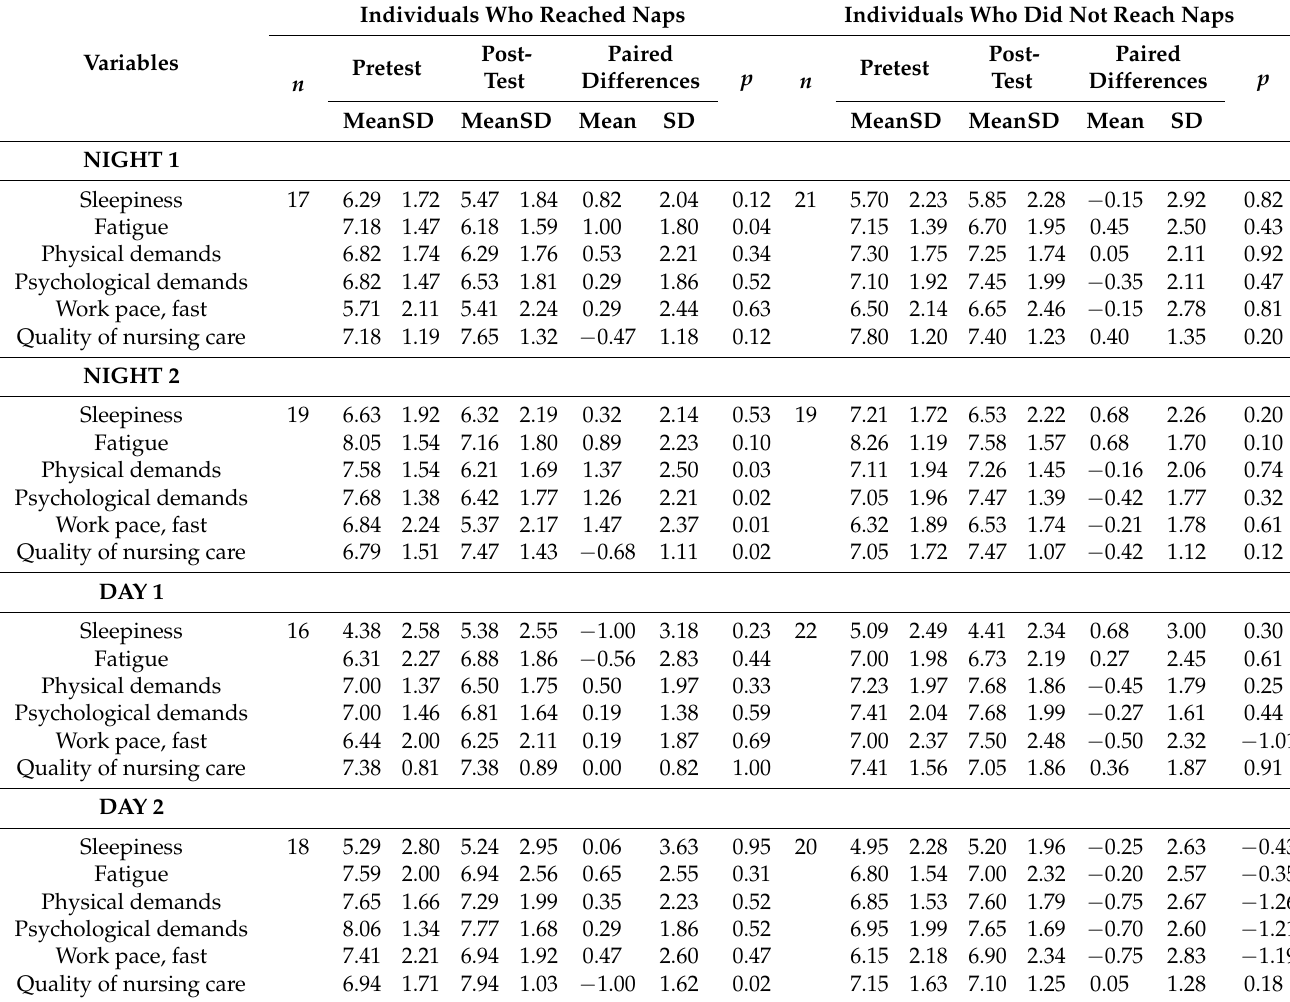
Table 2. Differences in self-reported sleepiness, fatigue, physical and psychological job demands, work pace, and quality of nursing care between pre- and post- tests, stratified by whether naps were